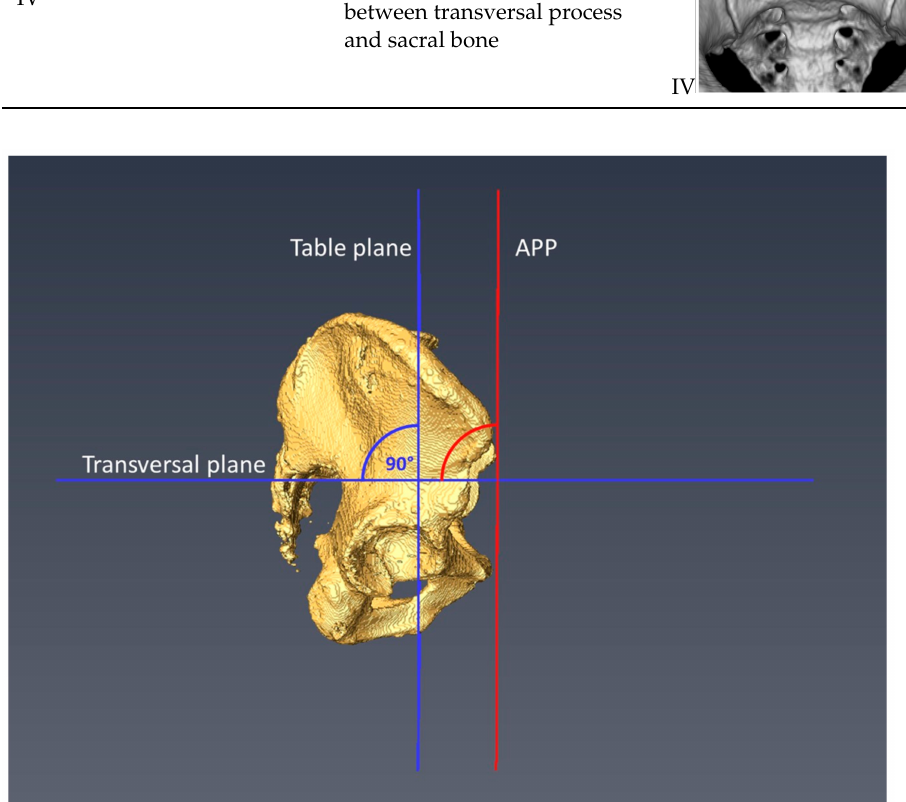
Figure 1. The measurement of the pelvic tilt in relation to the APP (anterior pelvic plane) is